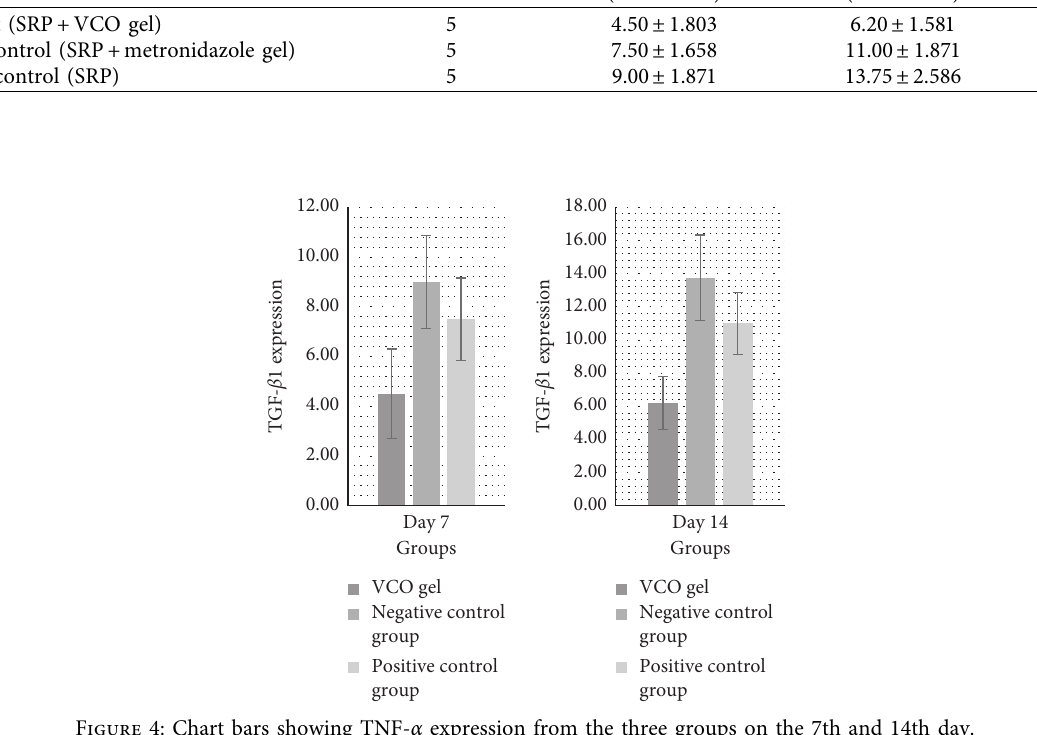
Table 2: Mean of TGF- β 1 on the 7th and 14th day in the respective treatment group. Group